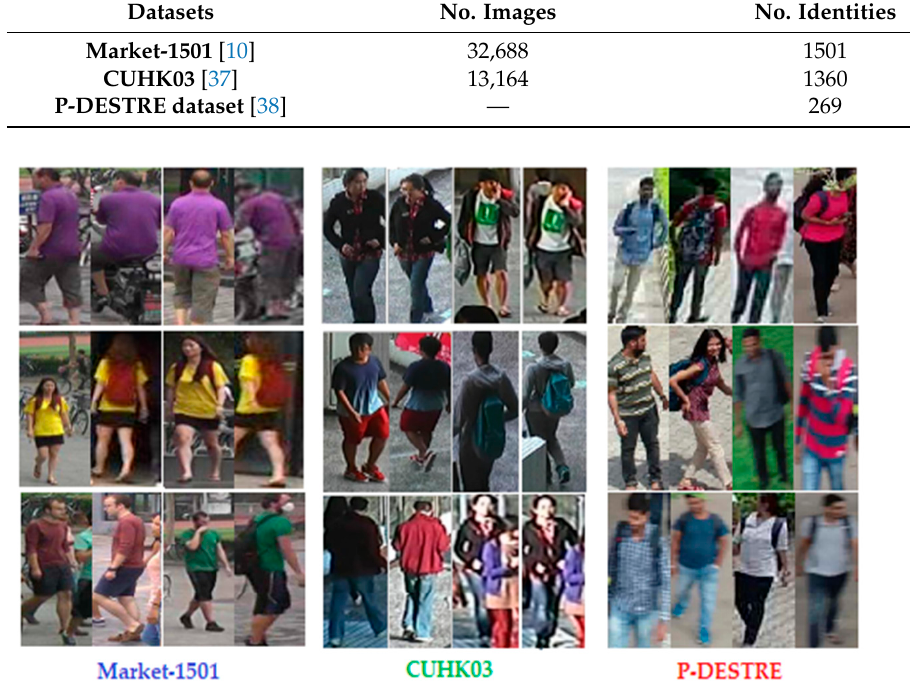
Figure 5. Sample images from the Market-1501, CUHK03, and P-DESTRE